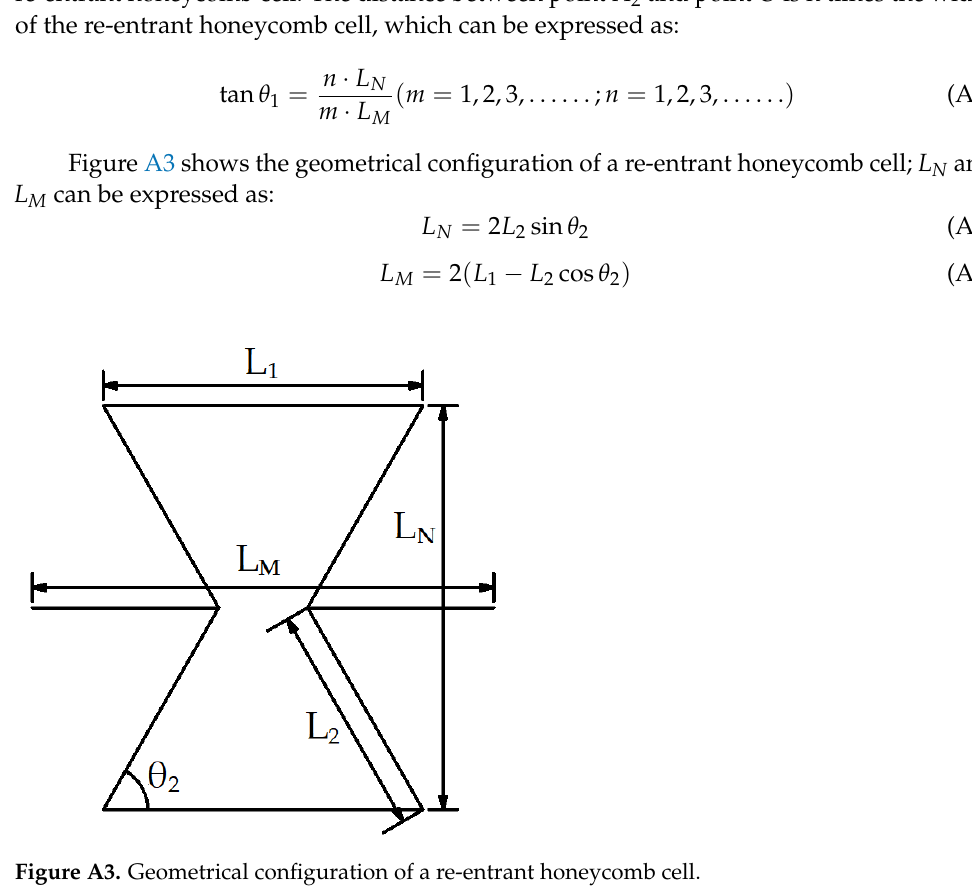
(A5) In this paper, the experiments mainly focused on the different orientations of honey- comb cylindrical shells. The geometrical configuration of re-entrant honeycomb cell did not change, which means that